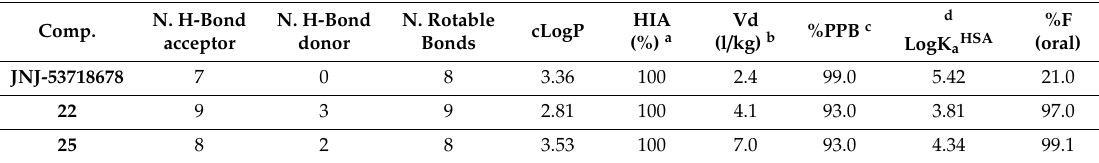
Table 4. Absorption, distribution, metabolism and excretion (ADME) descriptors related to absorption and distribution properties.